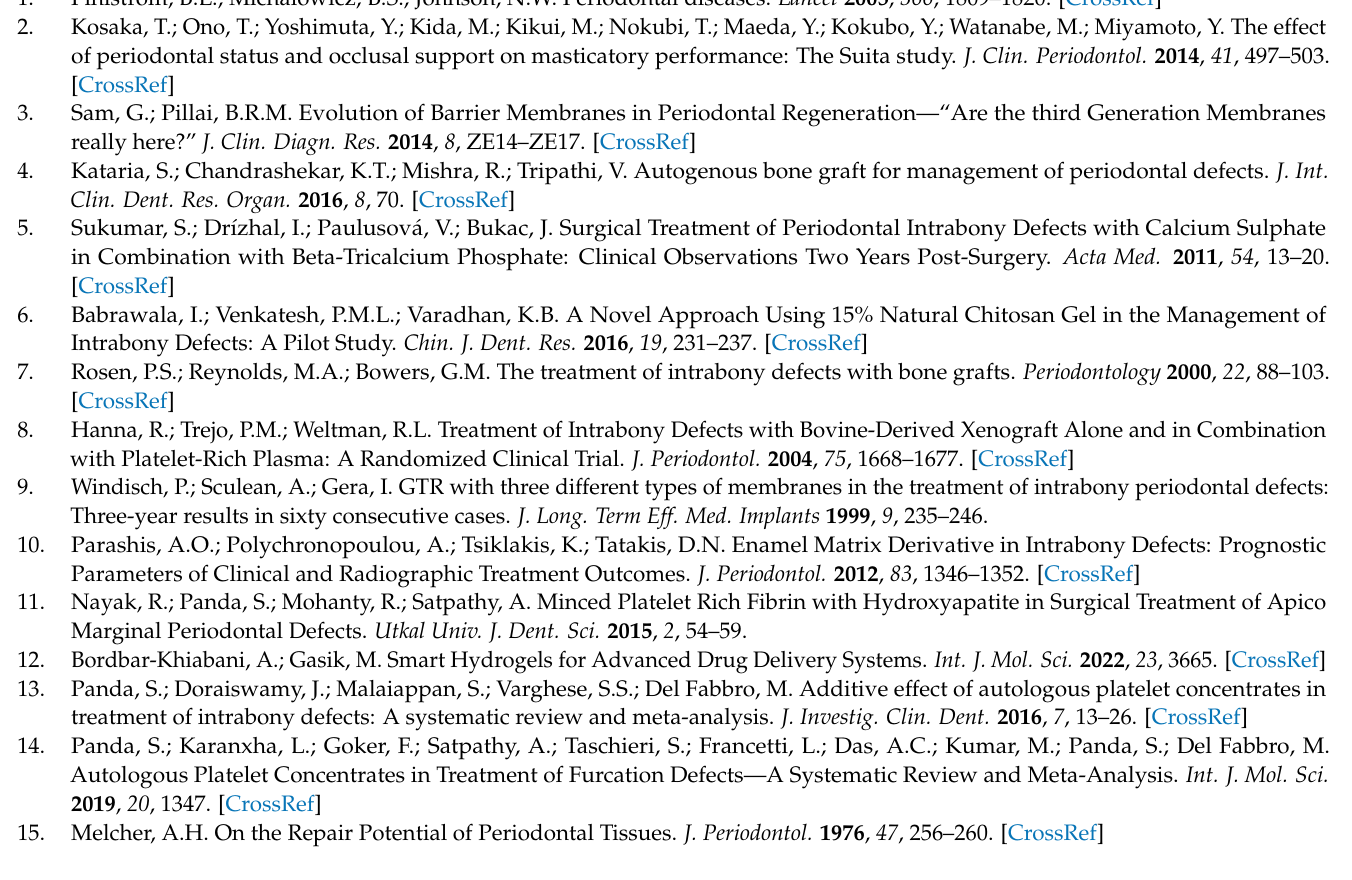
Figure A1. Funnel plots showing publication bias: ( A ) probing pocket depth; ( B ) clinical attach-ment level; ( C ) gingival recession; ( D ) intra bony defect depth.